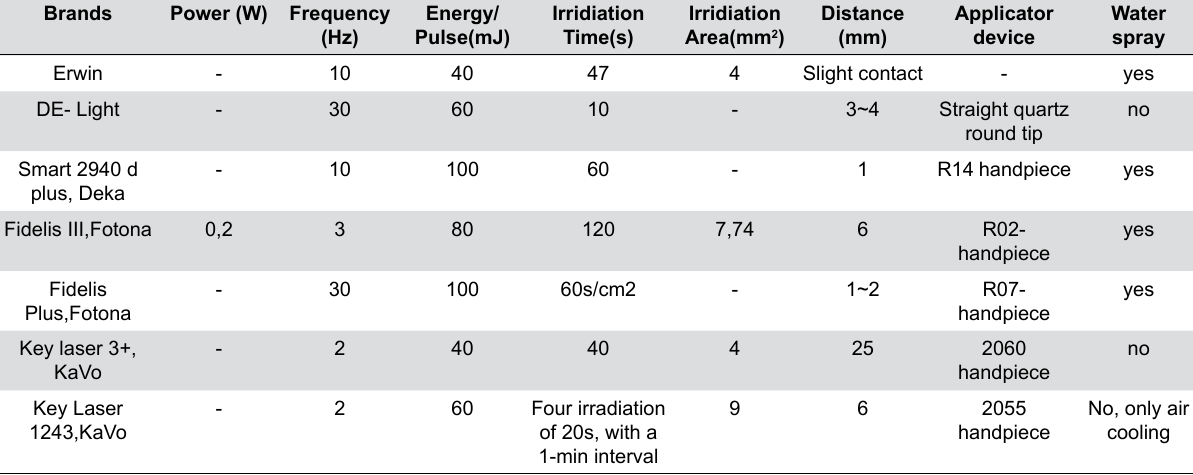
Table 1- Different Parameters of Er:YAG Laser of Different Brands Treating Dentin